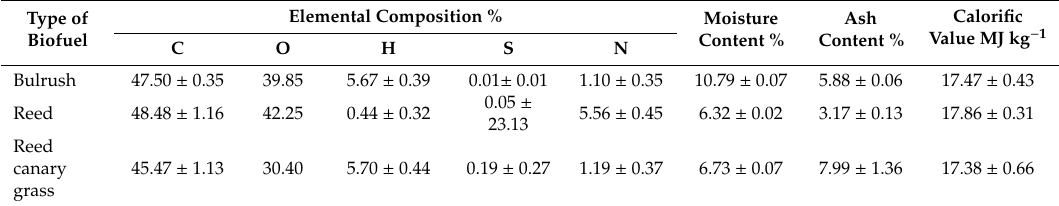
Table 2. Elemental composition and physical-mechanical properties of reed